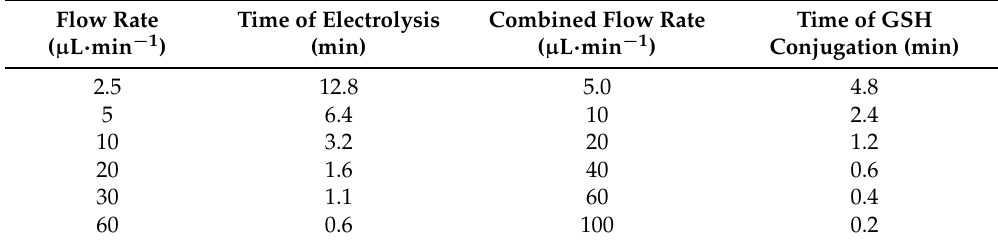
Table 1. Effect of flow rate in metabolic synthesis and GSH conjugation.